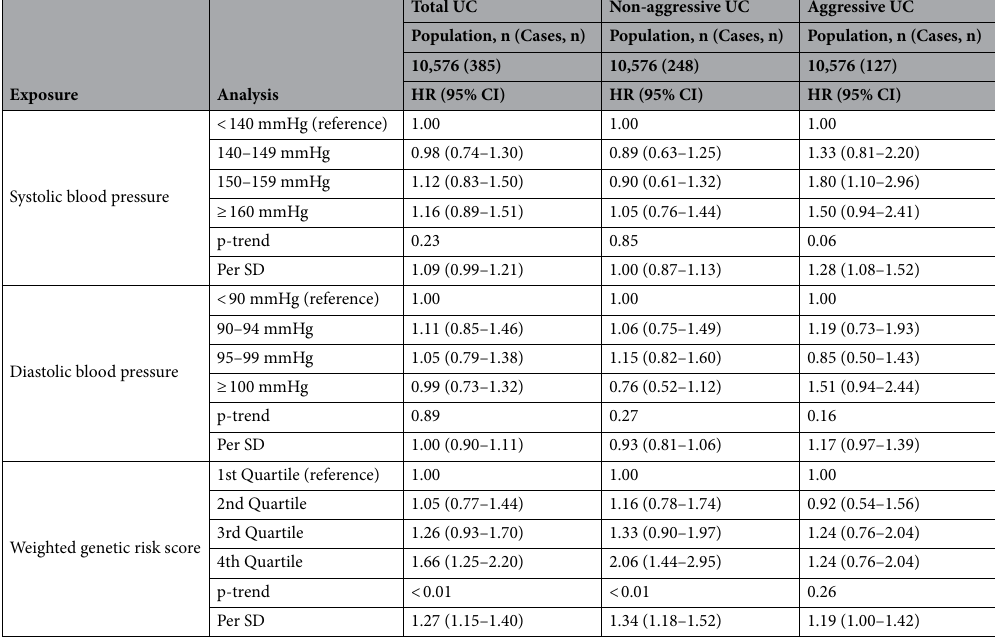
urothelial carcinoma, HR hazard ratio, CI confidence interval. Hazard ratios were calculated by Cox regression with age as the underlying time metric. Models were adjusted for categories of smoking, BMI, education, and physical activity. 10 individuals with incident UC cases had missing tumor data on muscle invasiveness. 405 (14 cases) individuals had missing genotype data (not included in analysis involving bladder cancer genetic risk score). The p-value for trend across categories was investigated by incorporating the categories of SBP, DBP and wGRS as a continuous variable in the regression model and testing its coefficient using the Wald